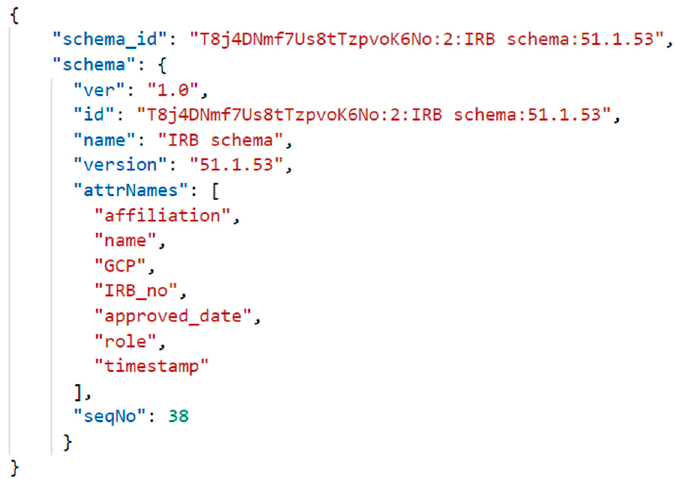
Figure 7. Schema definition for CDM identity issued by IRB.